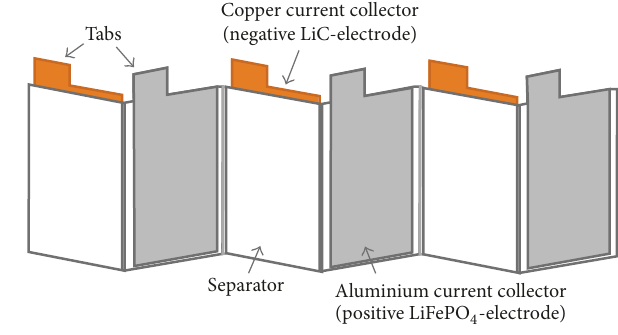
Figure 2: Cell core